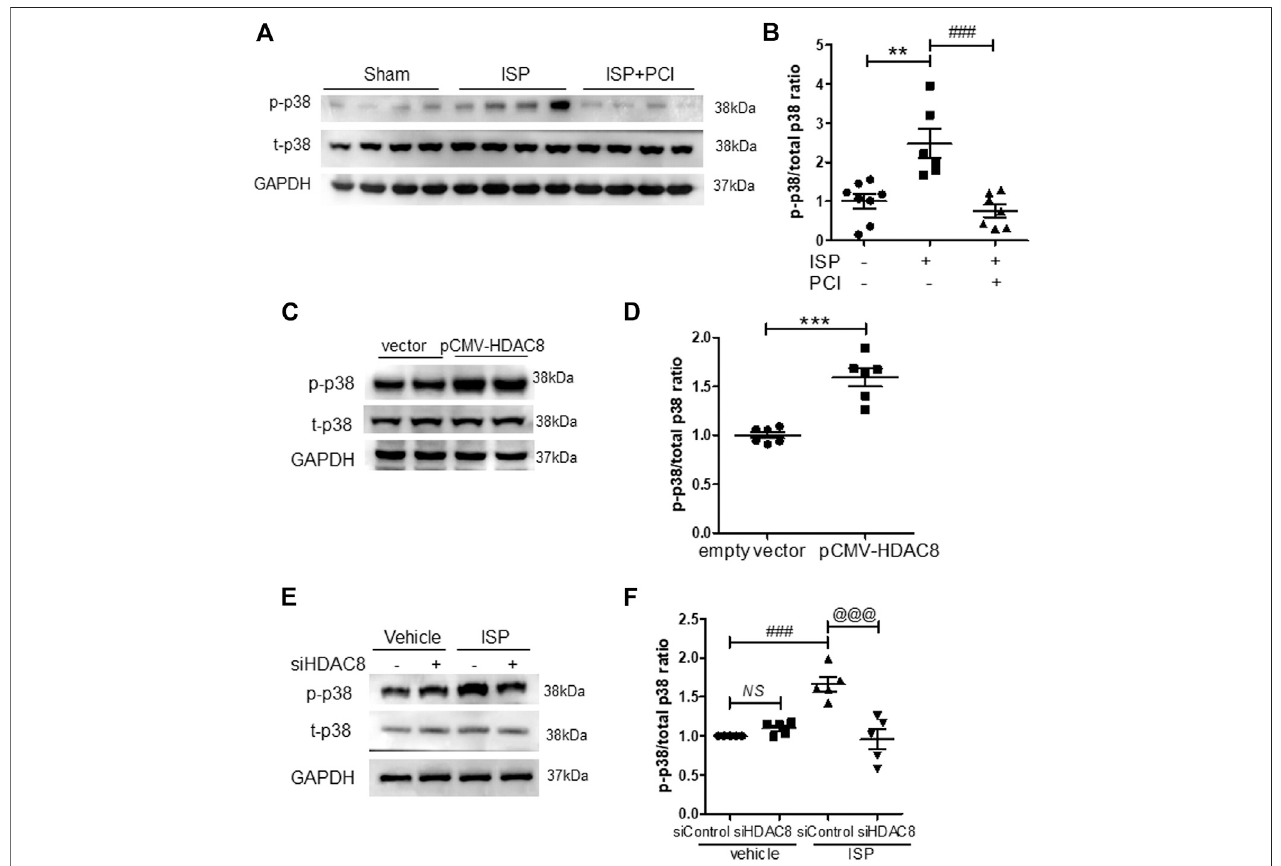
FIGURE 6 | Inhibition or knockdown of HDAC8 attenuates isoproterenol-induced phosphorylation of p38 MAPK in vivo and in vitro (A) PCI34051 (30 mg/kg/day, PCI)wasadministeredfor5 daysafterinfusionofisoproterenol(ISP)inmice.Representativewesternblotimagesofphosphorylatedp38inhearttissuesfromsham,ISP, ISP + PCI34051 treated mice (B) Quanti fi cation of phosphorylated p38 protein levels ( n (cid:2) 6 – 8). ** p < 0.01; ### p < 0.001 from one-way ANOVA followed by Bonferroni post hoc tests (C) H9c2 cells weretransfectedwithpCMV6-HA-Myc or pCMV6-HDAC8-HA-Mycfor48 h. Representativewestern blotimages ofphosphorylated andtotalp38inH9c2cells (D) Quanti fi cationofphosphorylatedp38proteinlevels( n (cid:2) 6).*** p < 0.001fromtheStudent ’ s t test (E) H9c2cellsweretransfectedwitheither control or HDAC8 siRNA and then stimulated with ISP for 9 h. Representative western blot images (F) Quanti fi cation of phosphorylated p38 ( n (cid:2) 5). ### p < 0.001; @@@ p < 0.001 from one-way ANOVA followed by Bonferroni post hoc tests ( I ) Proposed model: HDAC8 functions as anovel therapeutic target in isoproterenol-induced cardiac